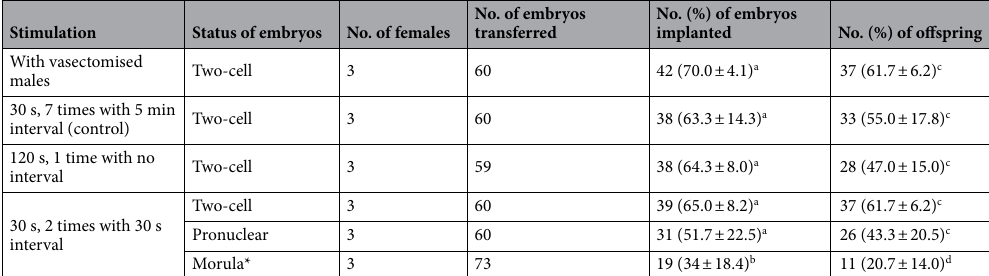
No. of embryos transferred